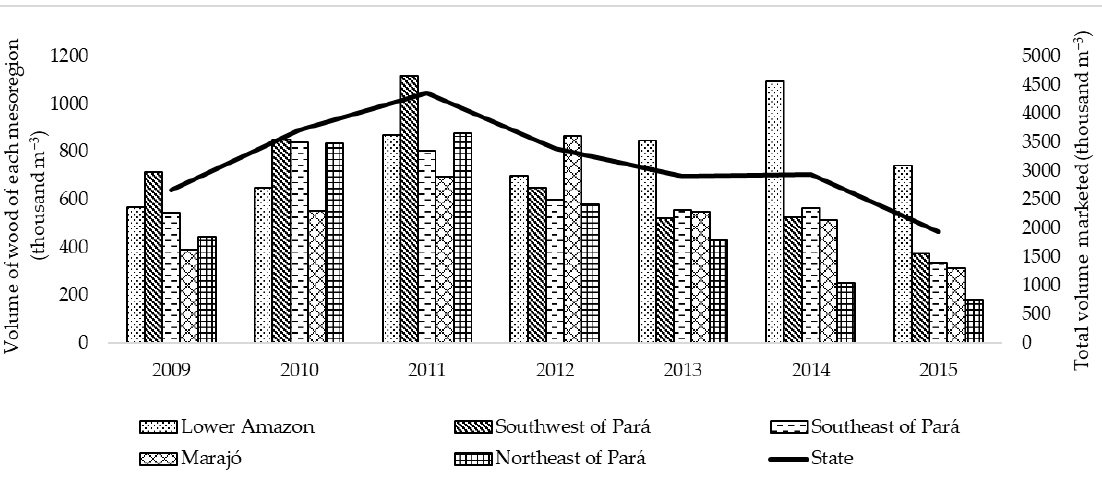
Figure 2. Volume of native wood of each mesoregion in relation to the total volume marketed in the state of Pará between the years 2009 and 2015.